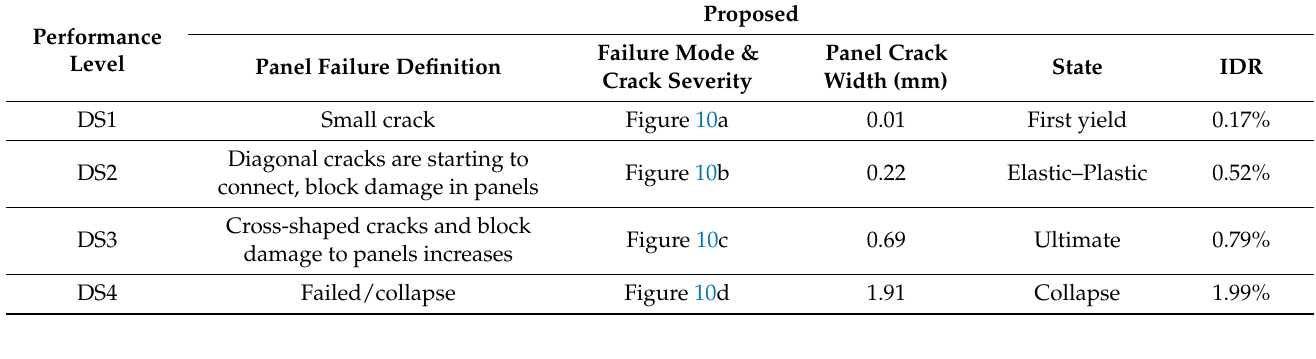
Table 8. Proposed Definition of Damage States for Infilled Frame based on Meso Model.